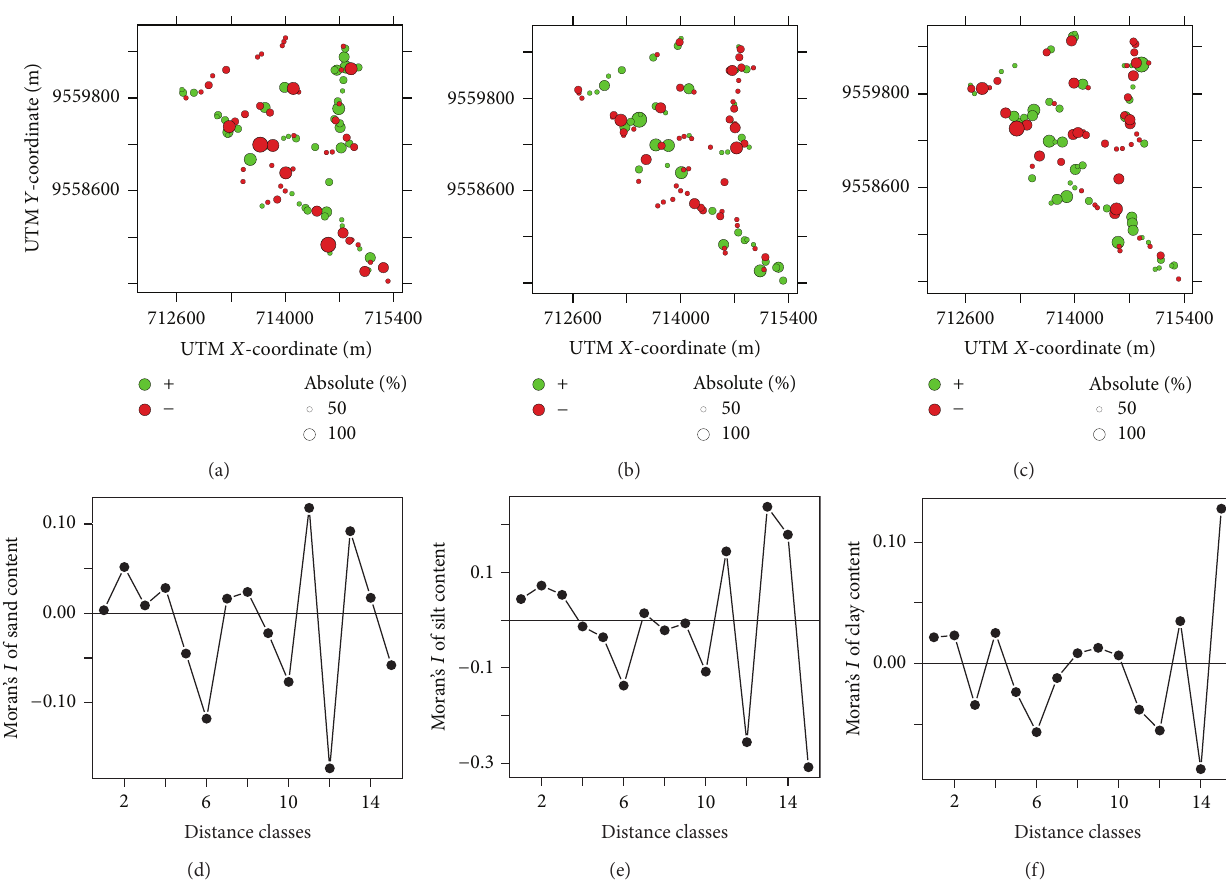
Figure 5: Spatial distribution of residuals in % of the maximum absolute residual value (red = negative values, green = positive values, top) and Moran’s 𝐼 (bottom). Models from random forest for ((a) + (d)) sand content, ((b) + (e)) silt content, and ((c) + (f)) clay